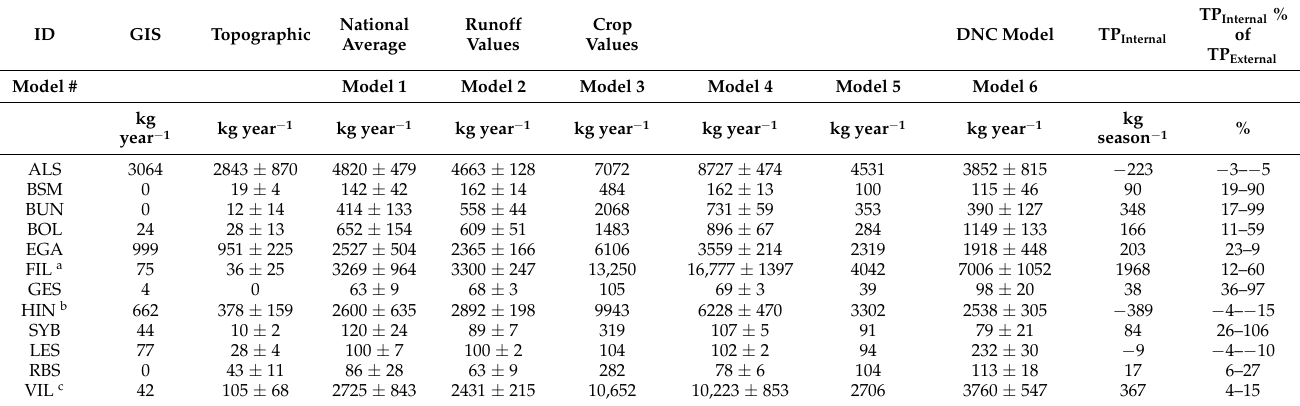
Table 2. External P-loading from point sources, external P-loadings (TP External ) calculated using the six methods, and the estimated internal P-loading (TP Internal